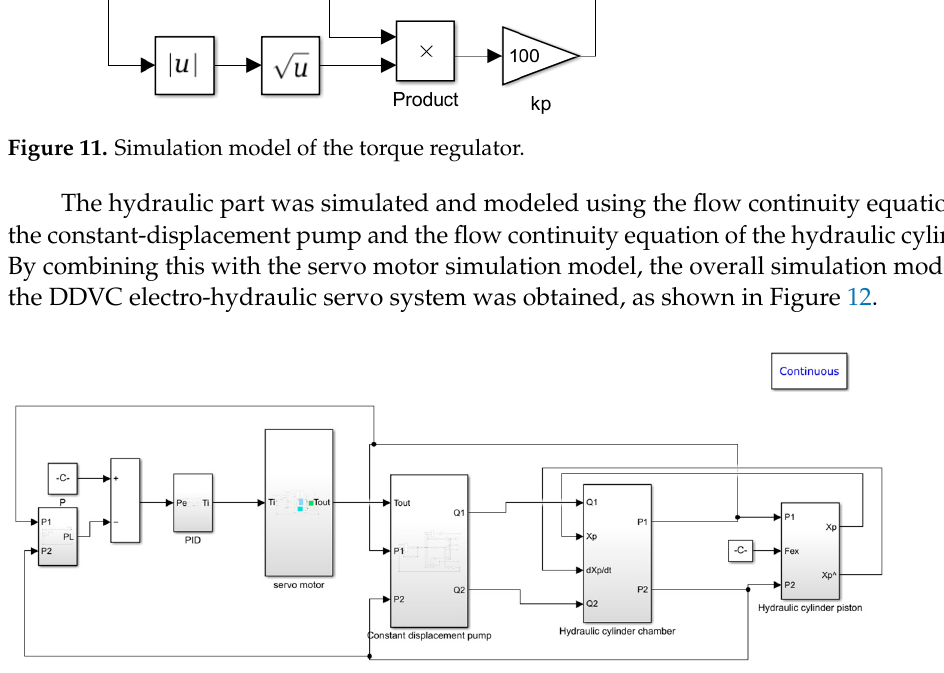
Figure 12. Overall simulation model of the DDVC electro-hydraulic servo system.